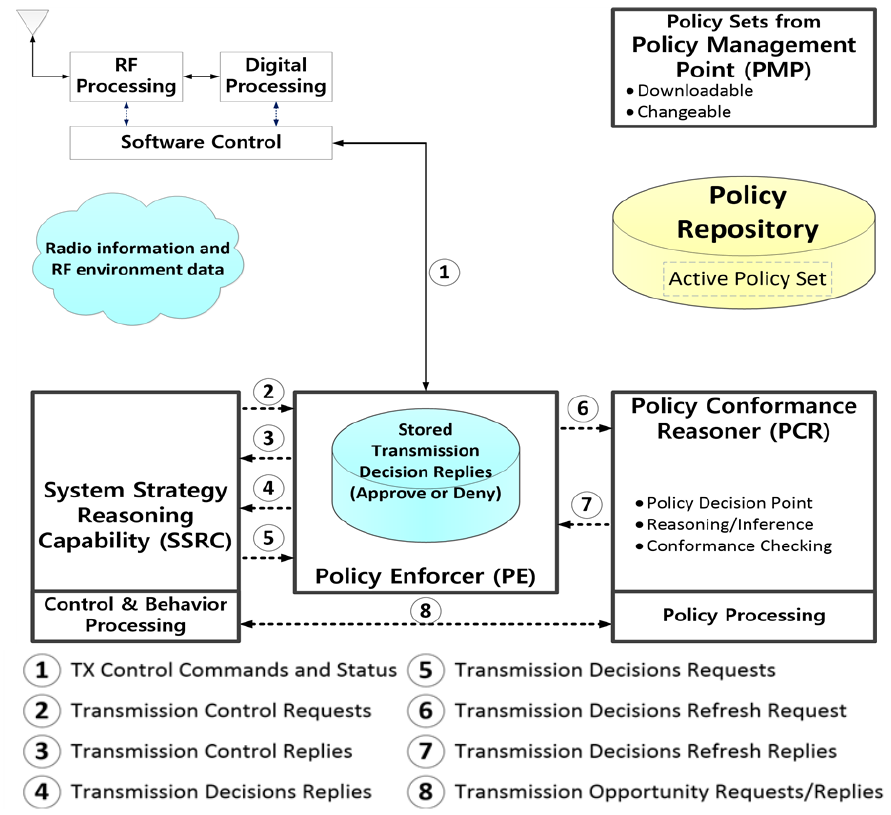
Figure 2. IEEE P1900.5-based cognitive radio engine processing